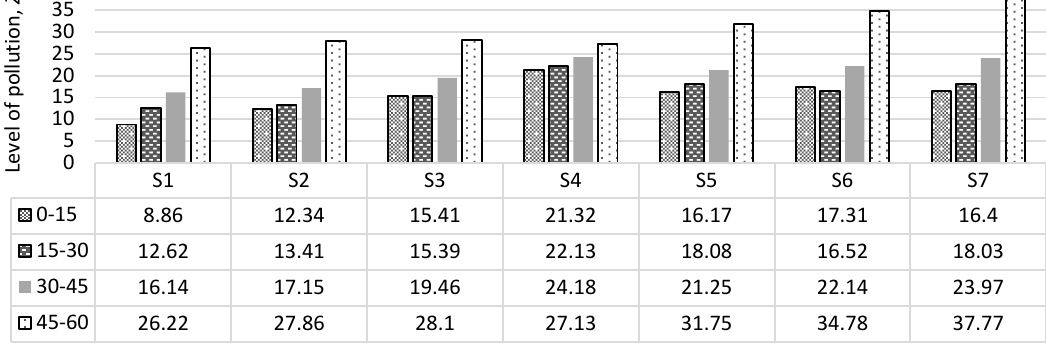
Figure 8. The level of pollution in sampling points of soil in different deep: 0–15 cm; 15–30 cm; 30–45 cm and 45–60 cm (S1, S2...S7—sampling points).